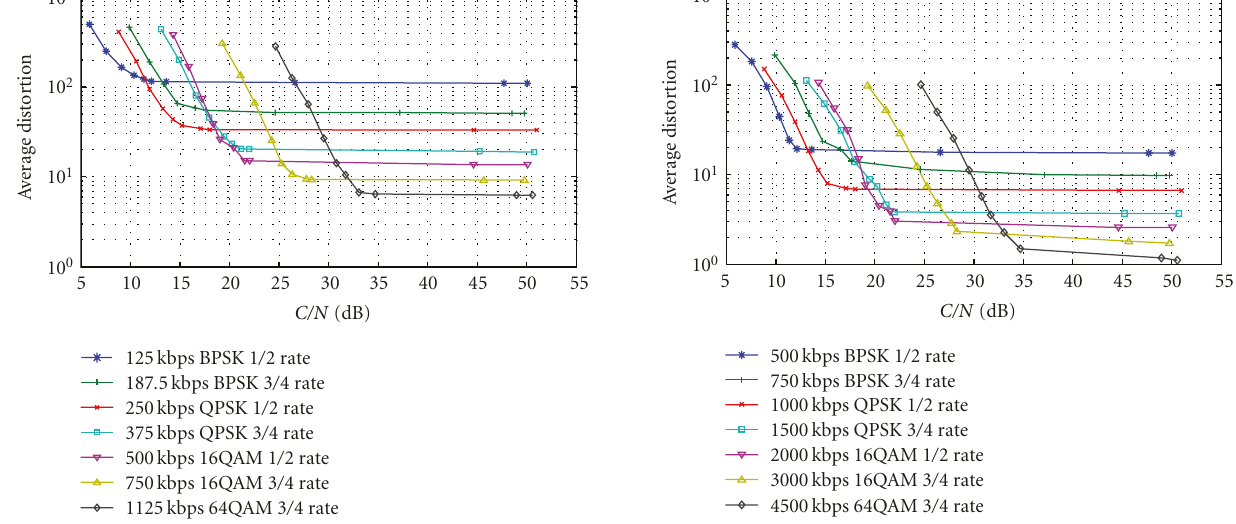
Figure 12: Optimum distortion-based link adaptation, foreman , GOP number 8, Set (a).